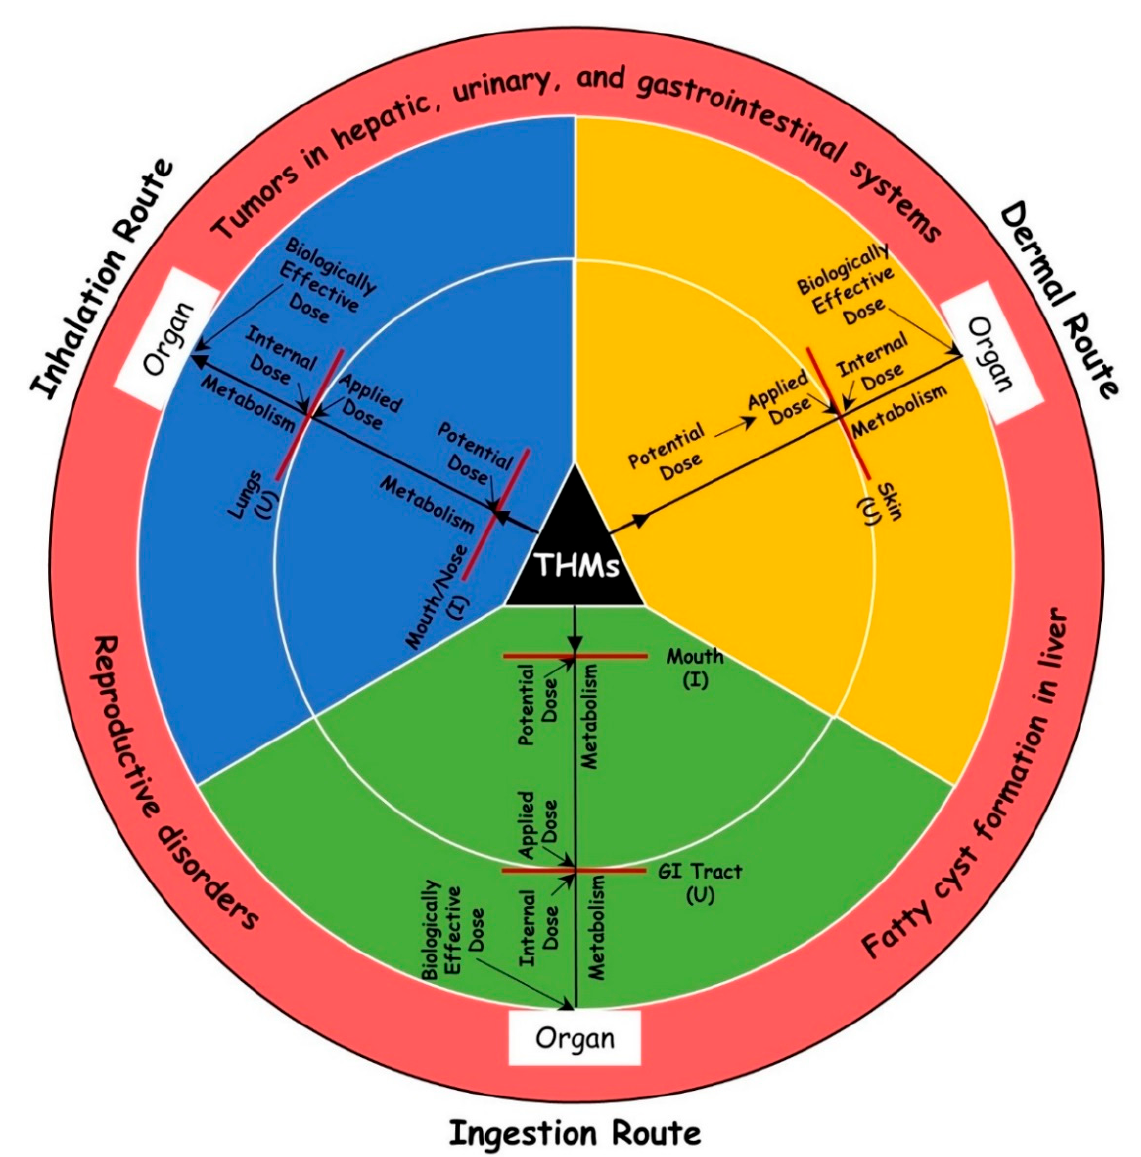
Figure 1. Schematic of source-to-effect of three exposure pathways of THM in human exposure models. Red lines are either exposure surface (a surface on a receptor where an agent is present) or absorption barrier (any exposure surface that can retard the rate of penetration of an agent into a receptor). I: intake; U: uptake; potential dose: the quantity of agent that go into a receptor after pass- ing an exposure surface that is not an absorption barrier; applied dose: the amount of agent at an absorption barrier; internal dose: the amount of agent that enters a receptor by crossing an exposure surface acting as an absorption barrier; biologically effective dose: the quantity of agent that reaches the target internal organ or tissue where the harmful outcomes arise. Table 1. Model input parameters and their distribution. Parameters Distribution and Values Reference